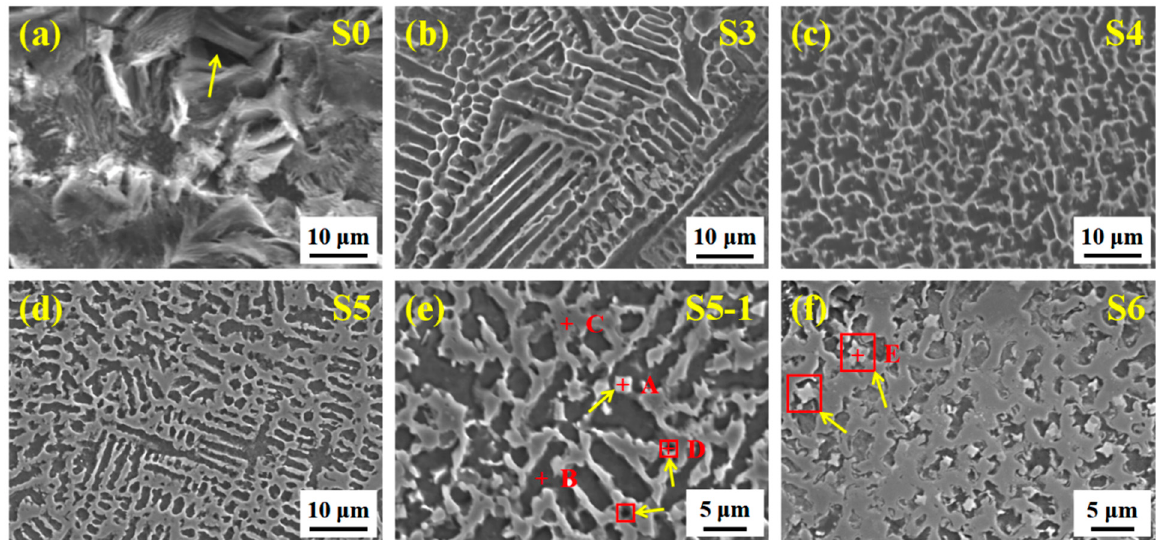
Figure 12. Corrosion surface morphology in Figure 11. ( a ) S0; ( b ) S3; ( c ) S4; ( d ) S5; ( e ) enlarged image of S5; ( f ) S6.